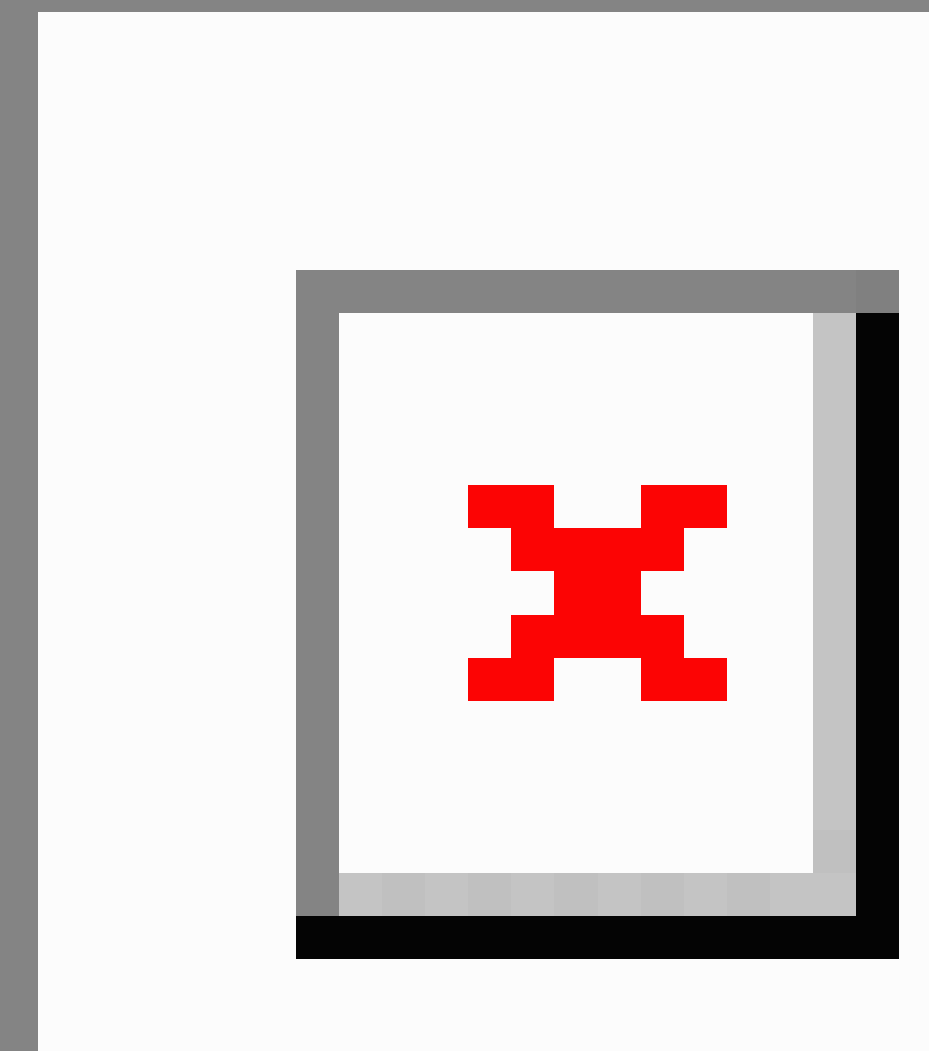
Figure 8. Trainer website features.